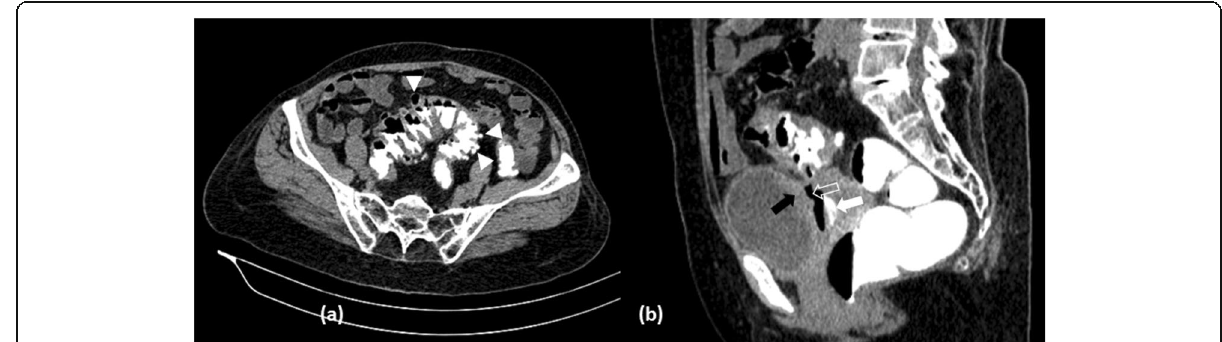
Fig. 1 Contrast-enhanced computed tomography (CT) images of the pelvis: axial image ( a ) in soft tissue window shows multiple contrast and air- filled diverticula arising from the sigmoid colon (solid white arrowheads). Sagittal reformat image ( b ) shows presence of an air-filled outpouching of sigmoid colon in the utero-vesical space (void white arrow). The rectally administered positive contrast media is seen to reach within the endometrial cavity (solid white arrow). Note is also made of thickening of posterior wall of urinary bladder (solid black arrow)